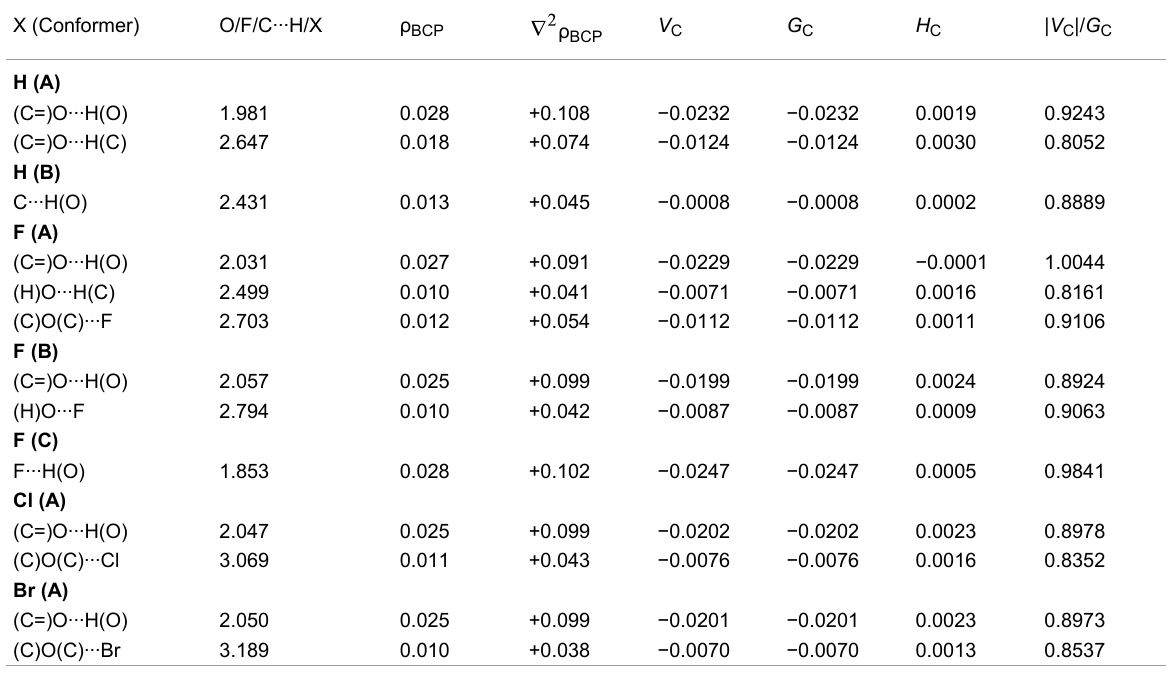
Table 2: QTAIM parameters a (a.u.) and O/F/C···H/X distance b (Å) obtained for selected interacting atoms.